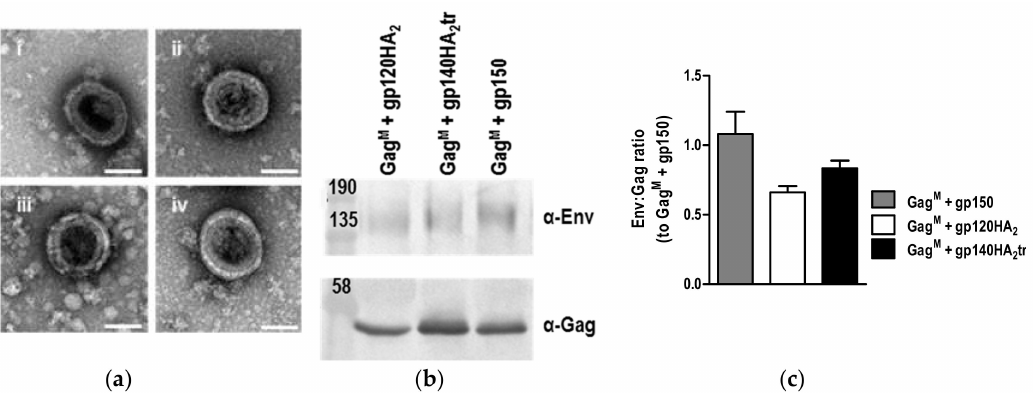
Figure 5. Analysis of virus-like particles (VLPs) formed by the DNA and MVA vaccines. ( a ) Negative staining of VLPs formed by HEK293T cells transfected with DNA vaccines expressing ( i ) Gag M + gp150, ( ii ) Gag M + gp120HA 2 , ( iii ) Gag M + gp140HA 2 tr, ( iv ) Gag M . Scale bars represent 100nm. ( b ) VLPs were isolated from RK13 cells infected with MVA vaccines by gradient centrifugation and analyzed by Western blotting. ( c ) Relative ratios of Env:Gag in VLPs were determined by densitometry analysis of Western